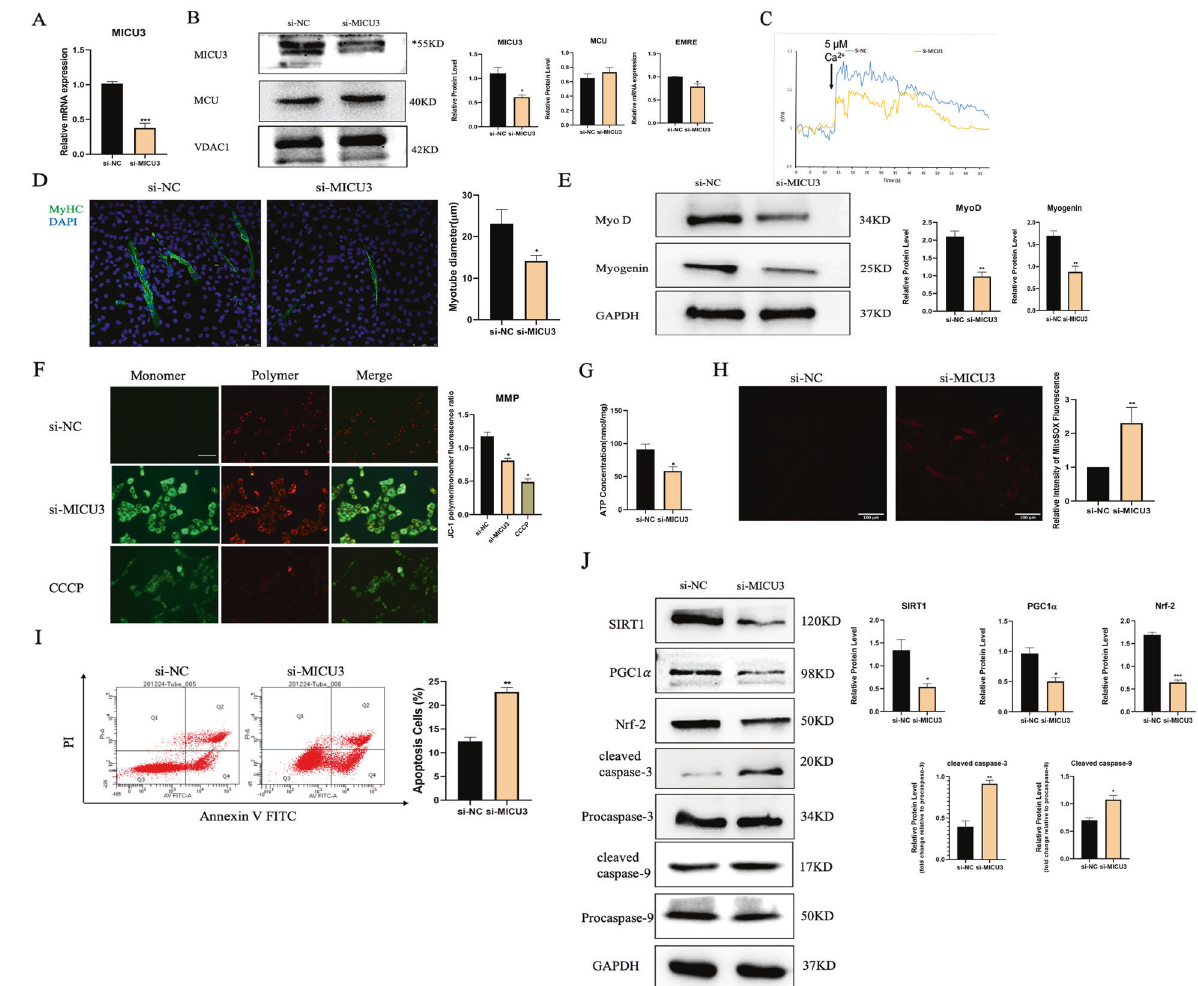
Fig. 2 Downregulation of MICU3 in C2C12 cells induced impairment of differentiation capacity and mitochondrial dysfunction. A The mRNA level of MICU3 in C2C12 cells. B Western blot and quanti fi cation for MICU3 and MCU, and mRNA level of EMRE. VDAC was used as the loading control for western blot, and GAPDH was used as the loading control for RT-PCR. *indicates target bands. C The mitochondrial calcium uptake assay in C2C12 cells. F 0 = Initial fl uorescence value, F = Arbitrary fl uorescence values. D The photo and quanti fi cation of myotubes (scale bar = 75 μ m). E Western blot and quanti fi cation for MyoD, and Myogenin. GAPDH was used as the loading control. F The fl uorescence staining for JC-1, indicator of mitochondrial membrane potential (scale bar = 100 μ m). CCCP was used as a positive control. G The ATP concentration of C2C12 cells. H The fl uorescence staining for MitoSOX, indicator of mitochondrial ROS (scale bar = 100 μ m). I Representative pictures of fl ow cytometry analysis in Annexin V- FITC/PI staining. (J)Western blot and quanti fi cation of SIRT1, PGC1 α , Nrf-2, cleaved